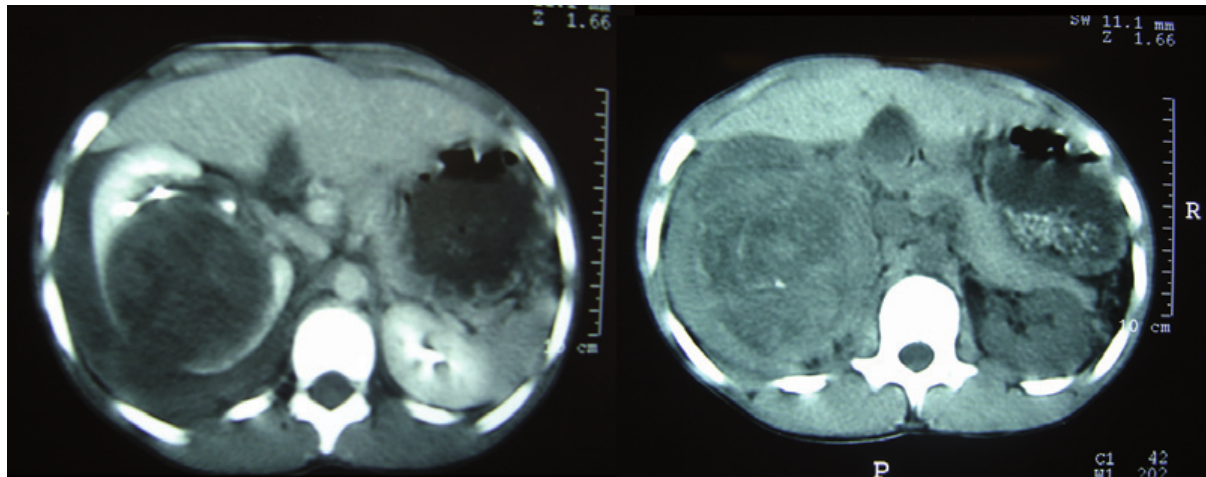
Figure 2 - CT of case 2: renal mass due to Wilms tumor with hemorrhage and calcifications.